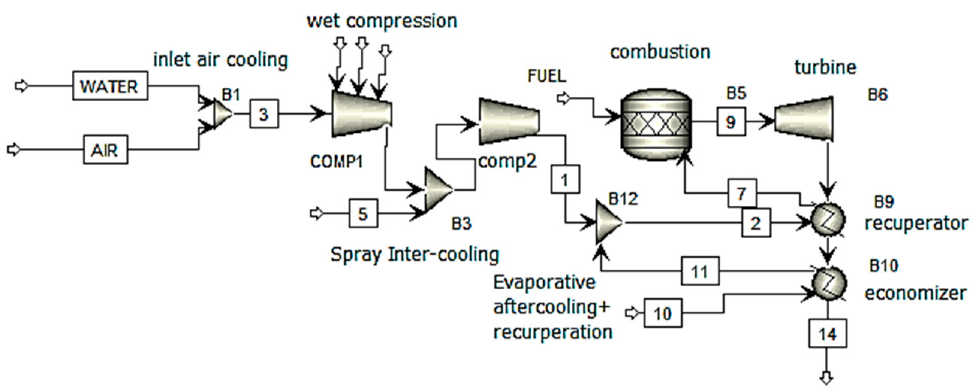
Figure 1. A system with wet compression, spray intercooling, evaporative aftercooling, and recovery of the cooled intake air (the water is delivered as a fog of water droplets or as a media cooler).